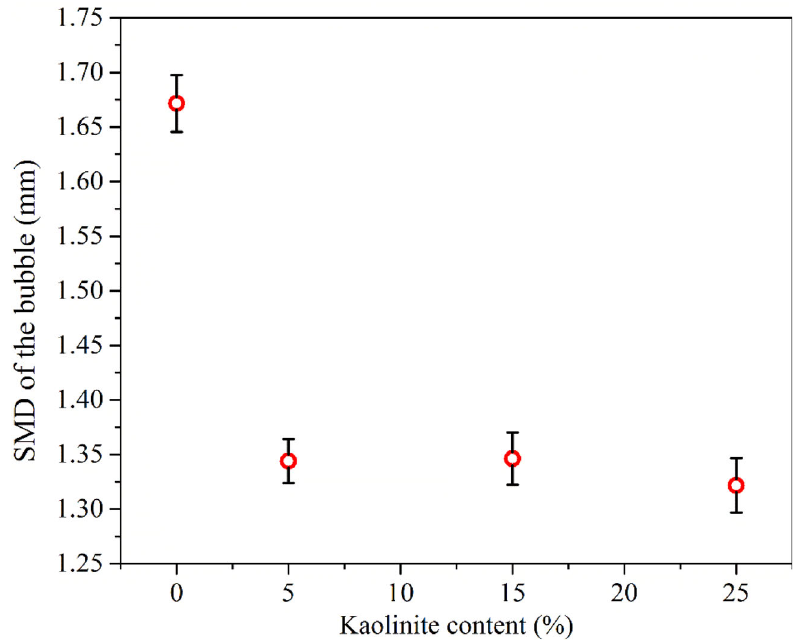
Fig. 8 Effect of ultrafine kaolinite content on SMD of the